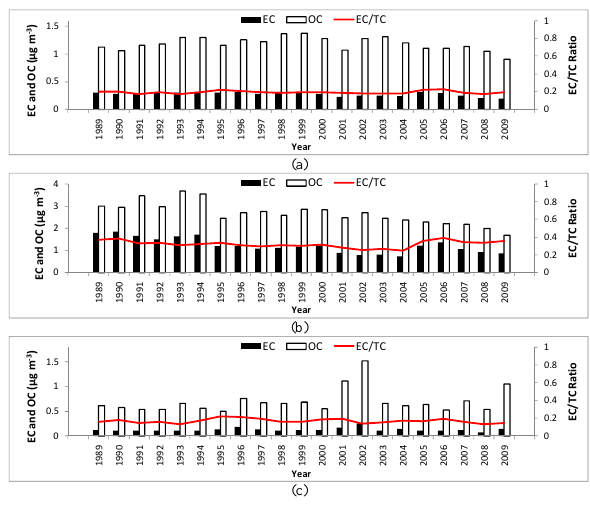
Fig. 1. Annual average elemental carbon (EC), organic carbon (OC), and the ratio of EC to total carbon (TC=OC+EC) for: (a) all IMPROVE data, (b) downtown Washington DC (U1), and (c) Bryce Canyon National Park (CP1) between 1989 and 2009. Data were acquired from the Visibility Information Exchange Web Sys- tem (VIEWS) website (http://views.cira.colostate.edu/). An EC in- crease from 2004 to 2005 corresponds with the carbon instrument upgrade for (a) and (b) , but this is not observed at every site, as shown in (c) .